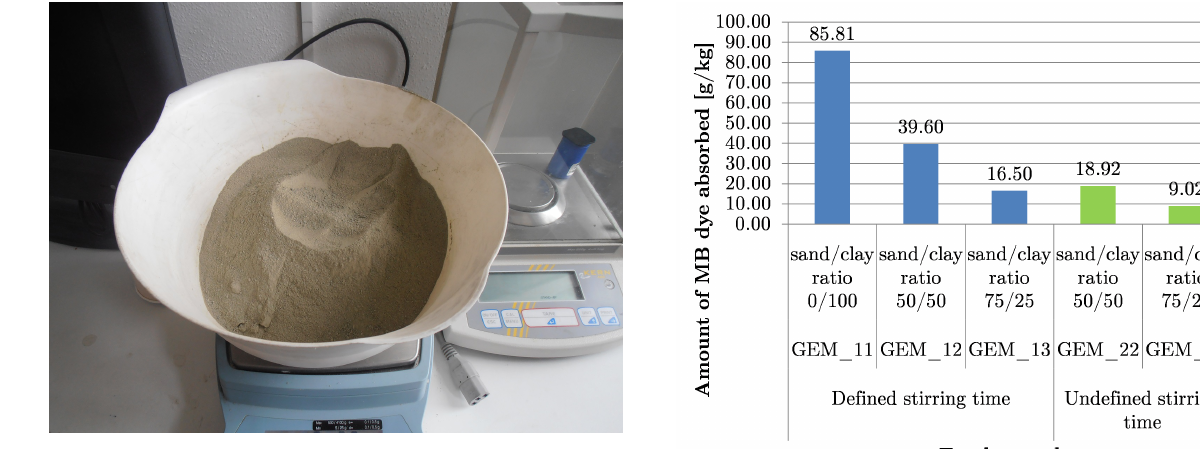
Figure 5. Montmorillonite clay.